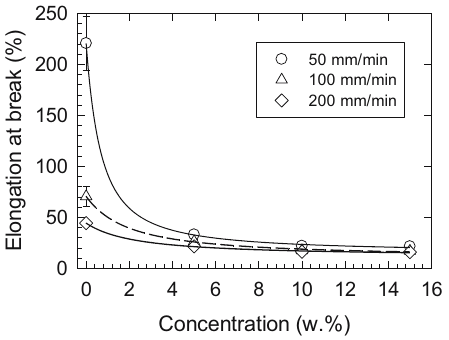
Figure 3: Elongation at break vs perlite fi ller concentration. Inset: applied deformation rates.